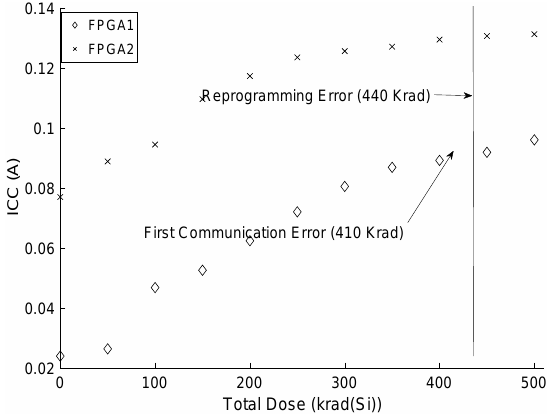
Figure 6. Internal Core Current vs. radiation.